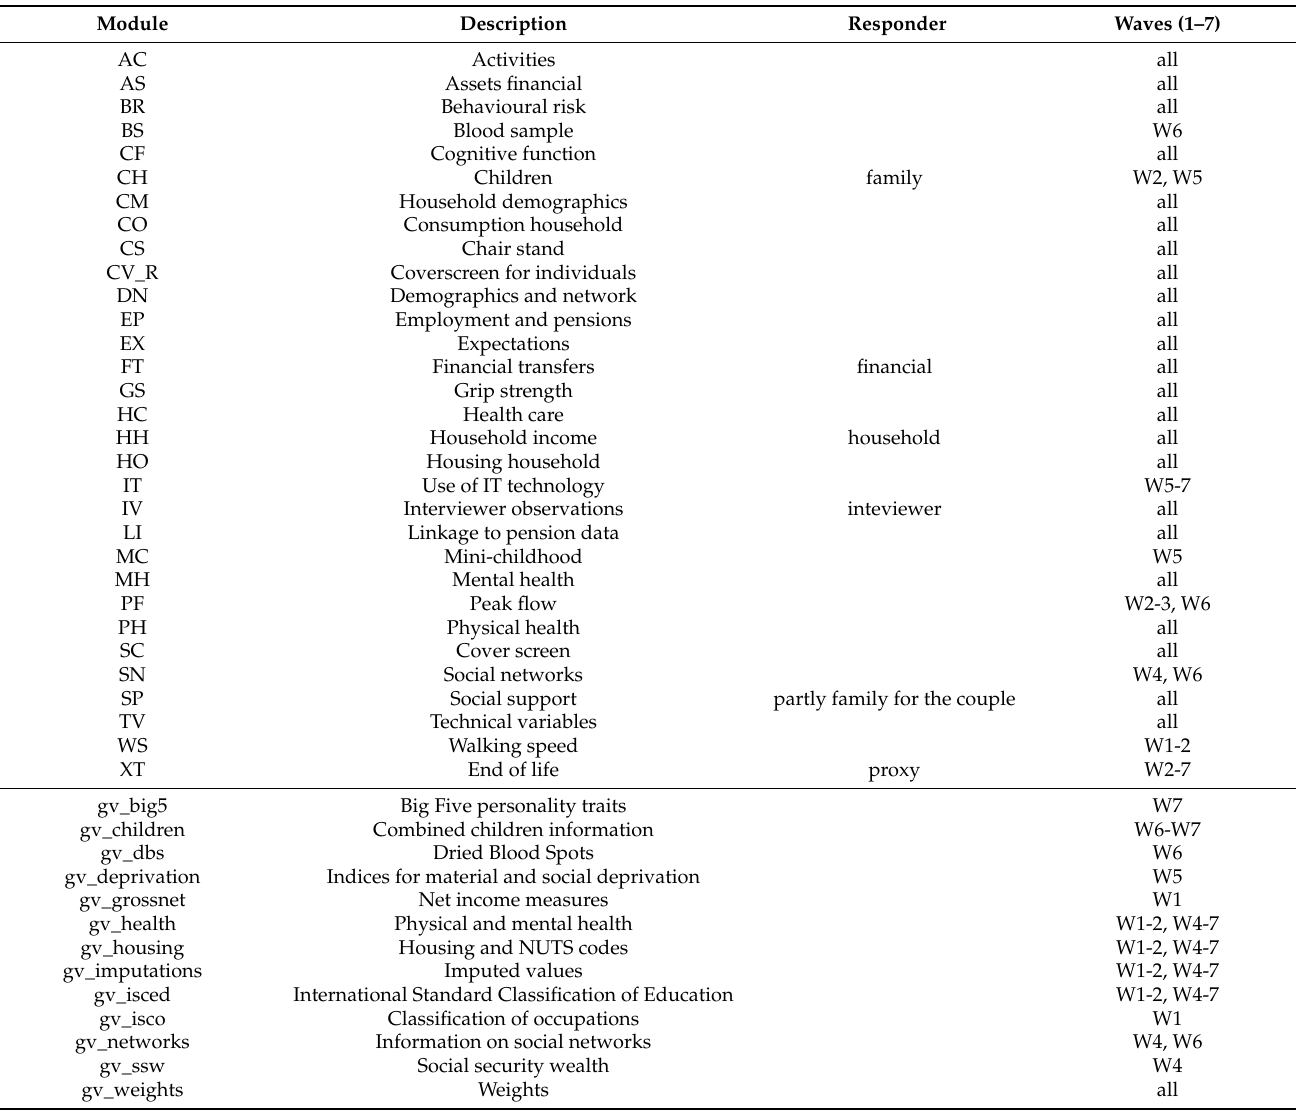
Table A1. List of the modules and type of responders; modules starting with gv are generated variables modules. Module Description Responder Waves